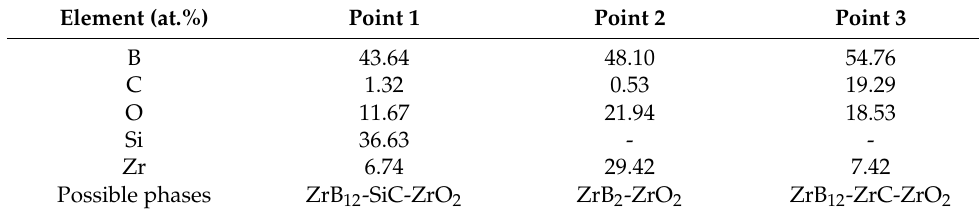
Table 4. EDS results of three positions in Figure